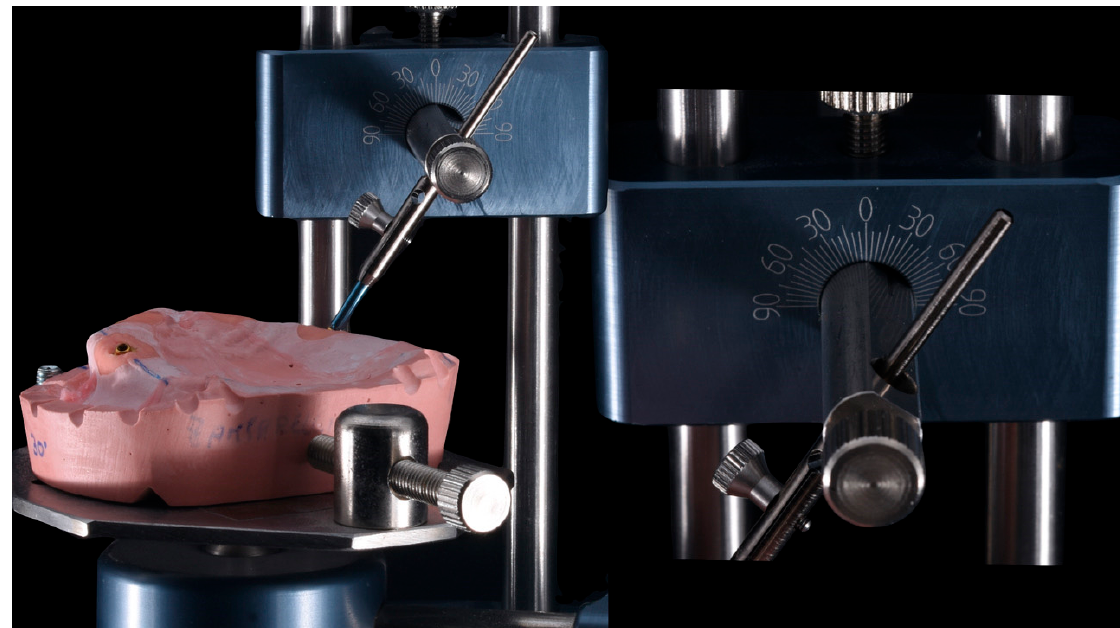
Figure 6. Model placed on the parallelometer.